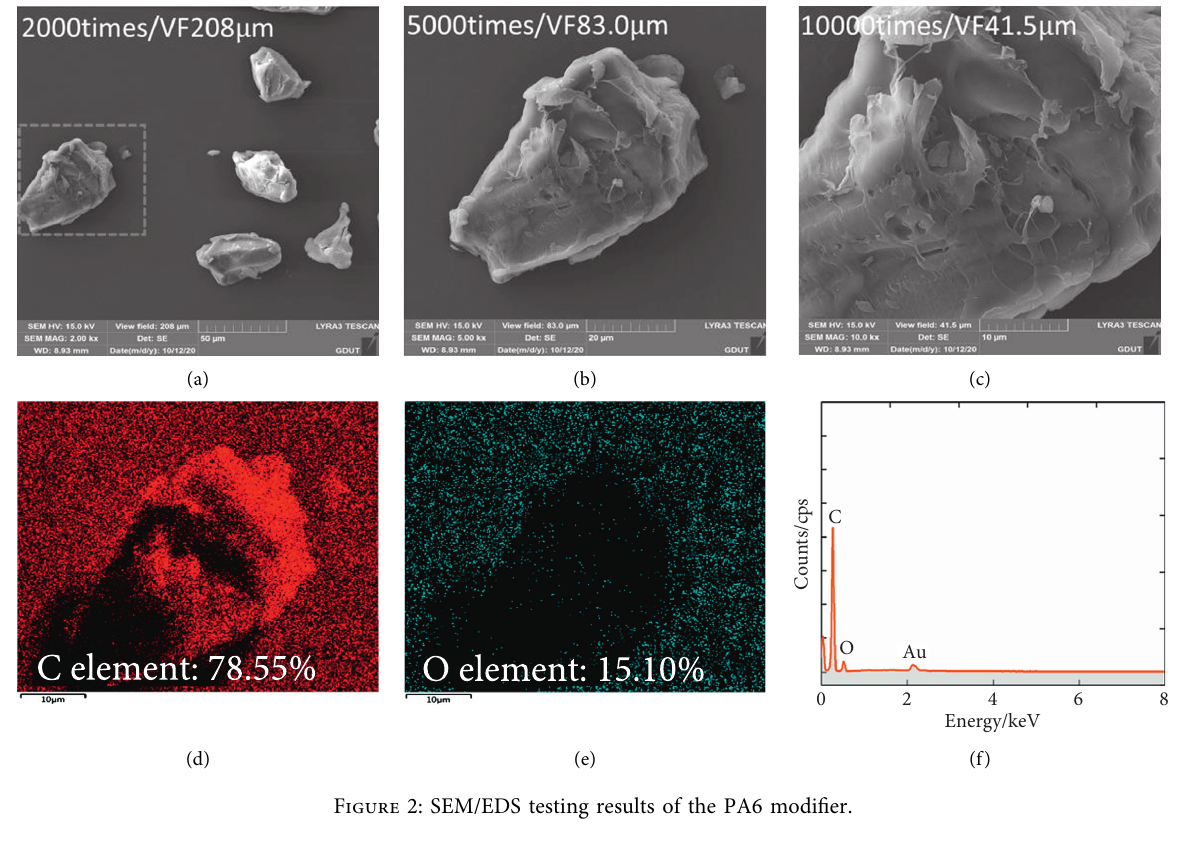
Figure 2: SEM/EDS testing results of the PA6 modifier.